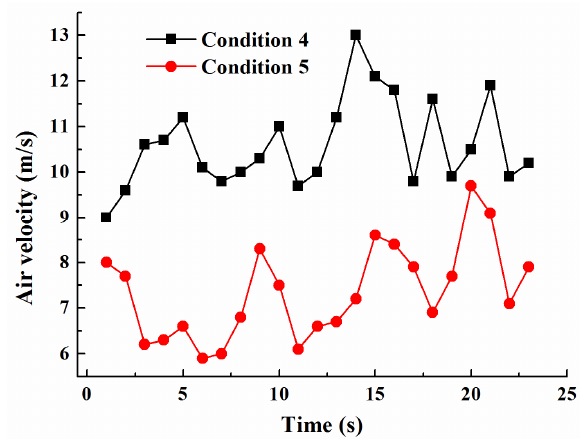
Figure 13. Variation of air velocity under relative-motion conditions.